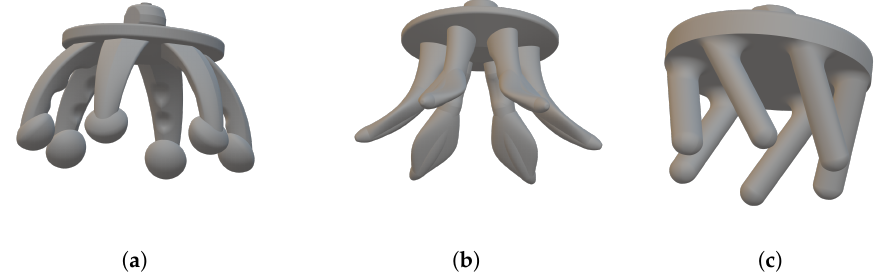
Figure 3. 3D-printed electrode shapes investigated. All have a 1.5-mm snap connector on the upper side and are shown here with six fingers present. ( a ) Spider electrode. ( b ) Anti-spider electrode. ( c ) Spiny